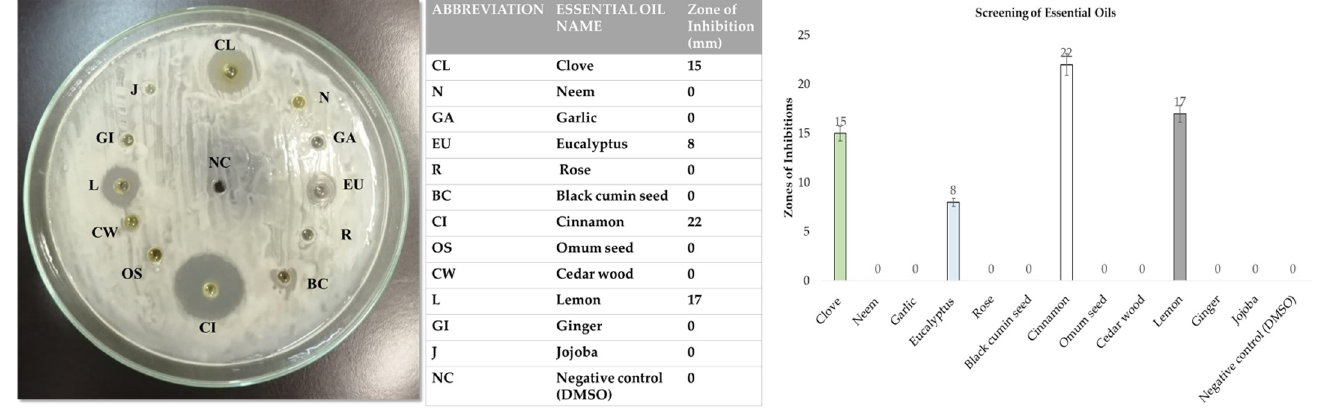
Figure 3. Screening of essential oils using the agar well diffusion method against S. aureus.